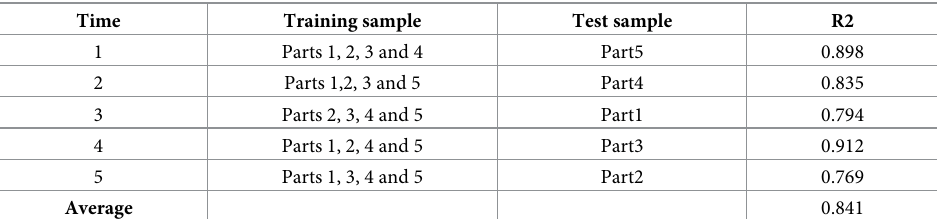
Table 3. Accuracy of training with different data